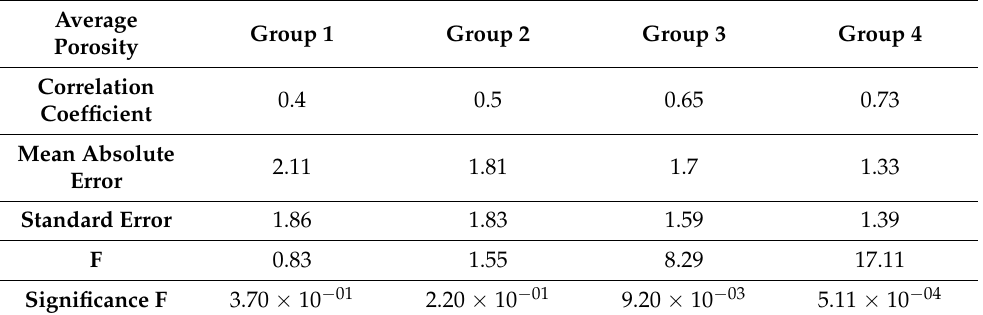
Table 3. Correlation coefficient and mean absolute error (PU), standard error, F, and Significance F for the actual versus predicted average porosity over a 20-ms window below the main